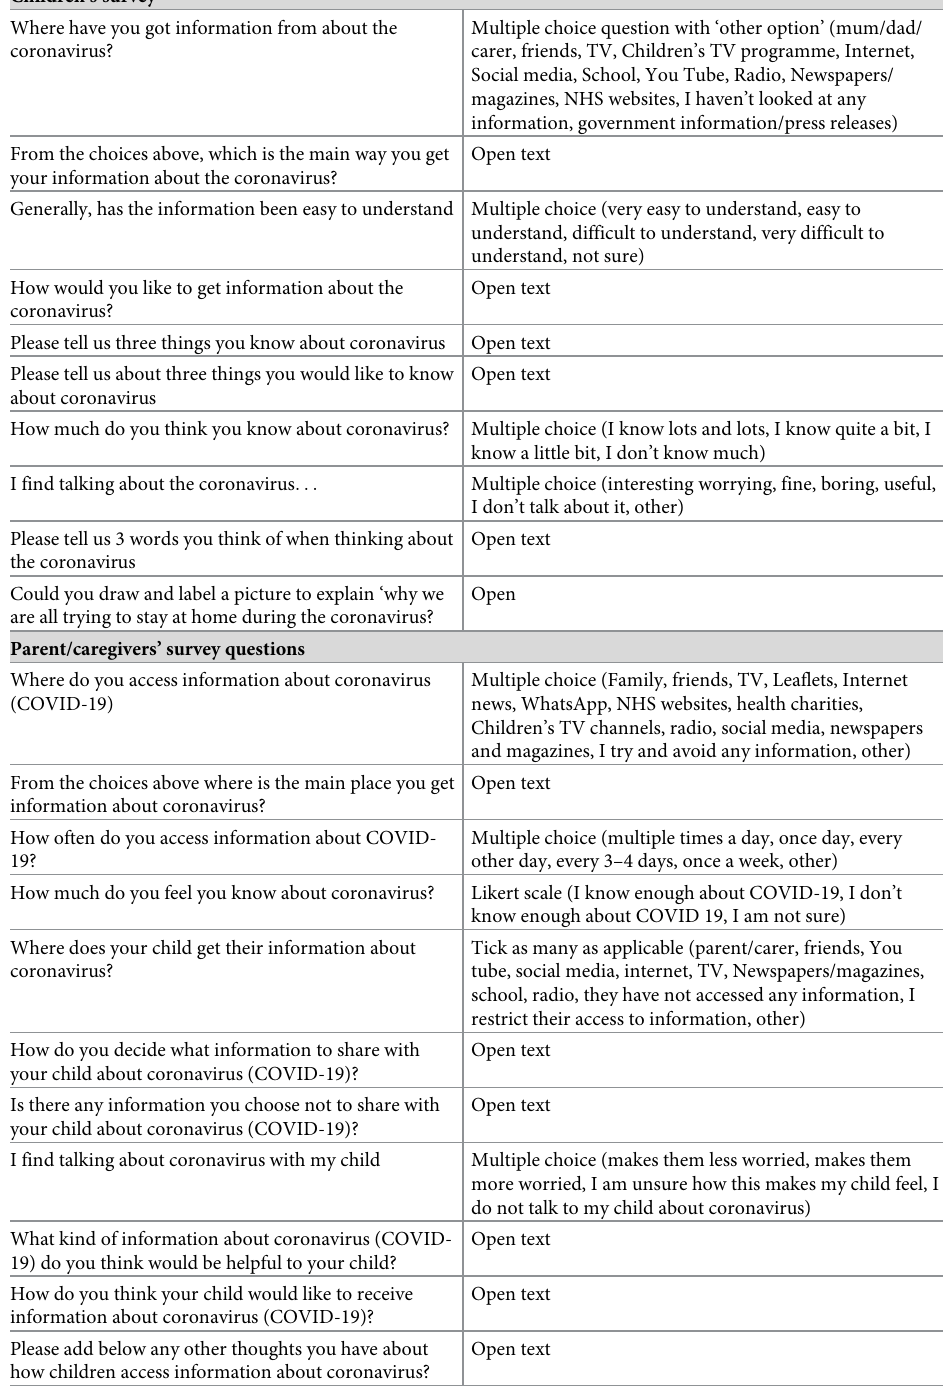
Table 2. Questions in the child and parent/caregiver survey. Children’s